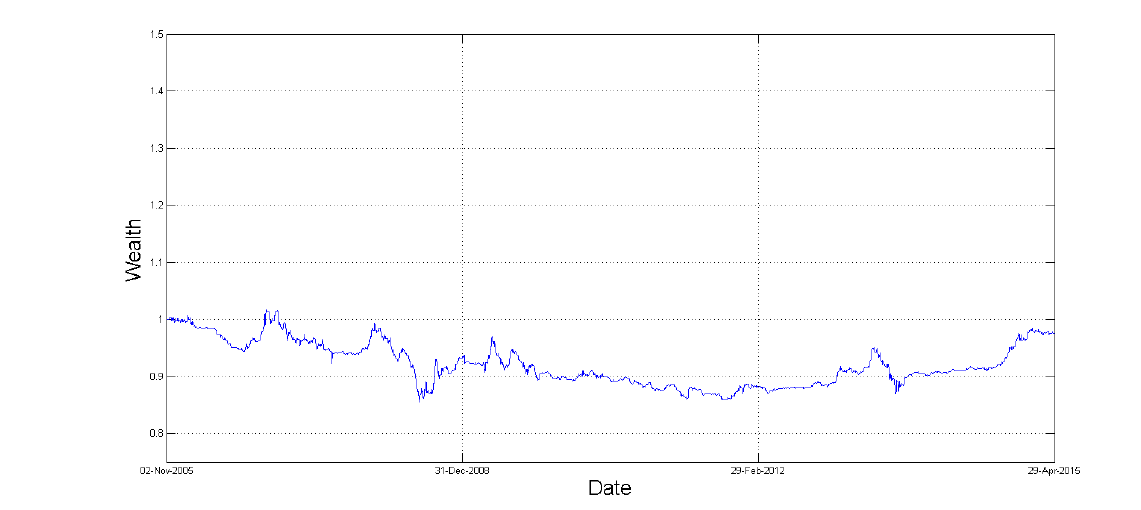
Figure 8. Ex-post wealth on Indian bonds after second